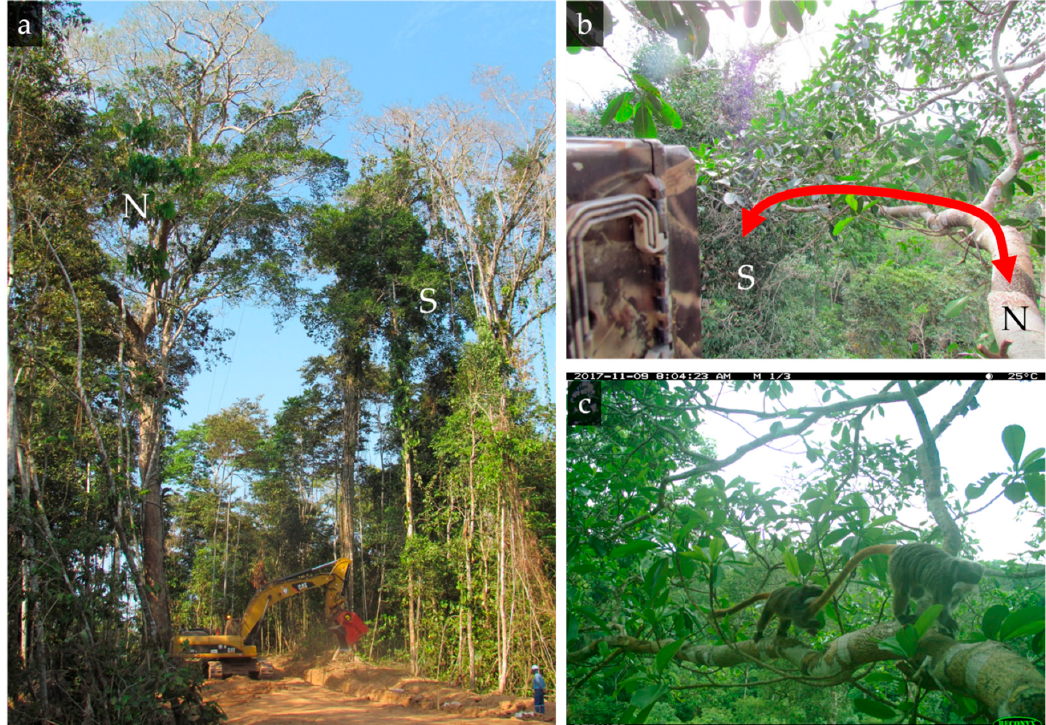
Figure 2. ( a ) One of the NCBs that was monitored with three camera traps for the three connections of branches between the tree on the north (N) and south (S) sides of the RoW, ( b ) the orientation of one of the three camera traps (see camera in the bottom left of the image) in the bridge, with the travel path it captured indicated by the red arrow, and ( c ) an example of a camera trap image of a crossing event by two emperor tamarin monkeys ( Saguinus imperator ).